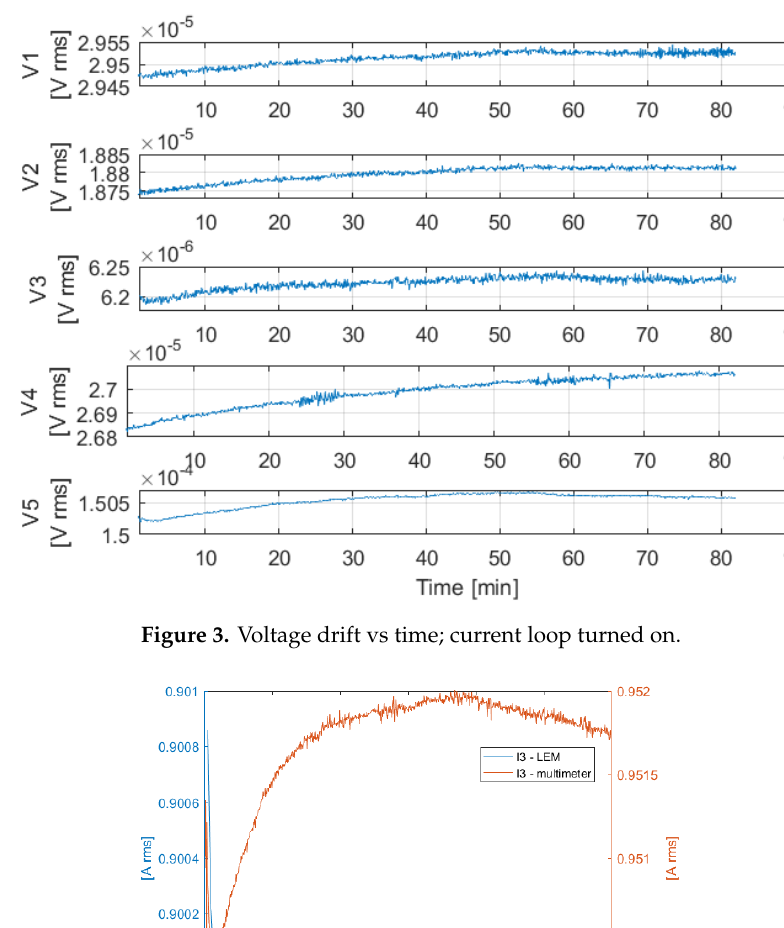
Figure 4. Current measured with a Hall effect sensor and with a multimeter – channel 3.